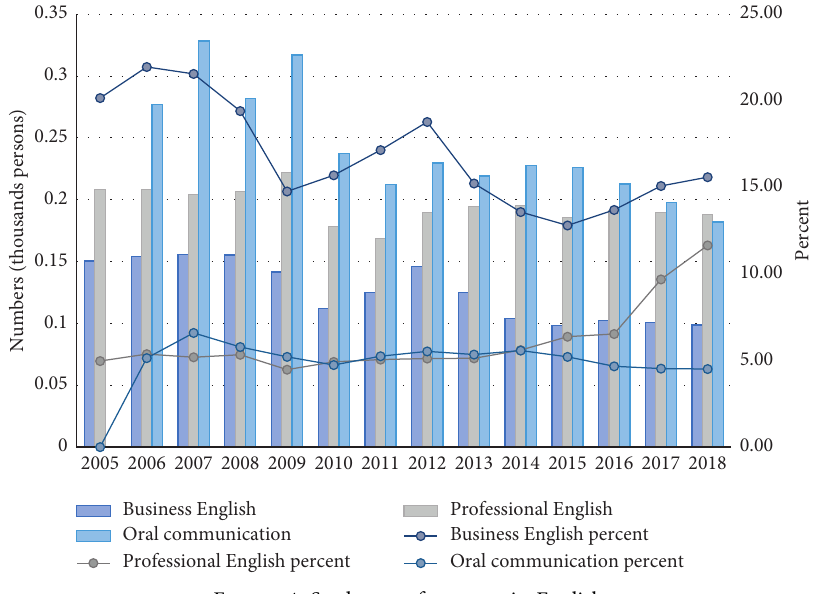
Figure 4: Student performance in